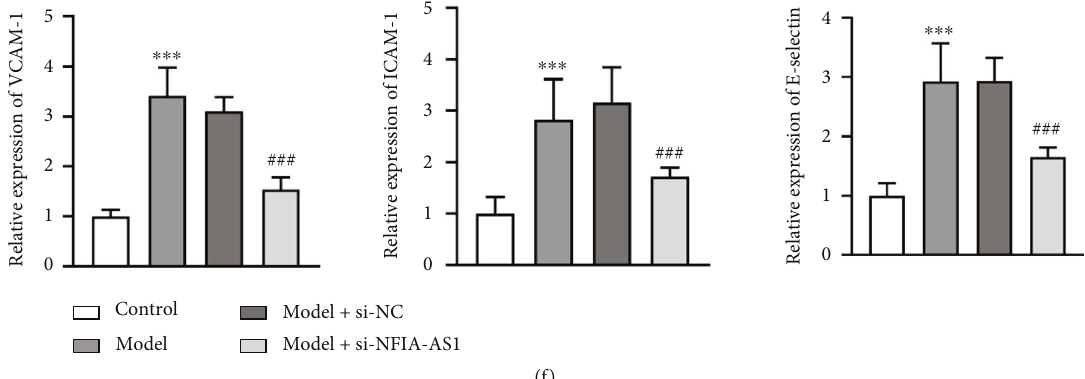
Figure 7: Inhibition of NFIA-AS1 improves the symptoms of AS. The relative expression of NFIA-AS1 (a), miR-125a-3p (b), and AKT1 (c) in control and AS model groups. *** P < 0 : 001 . (d) H&E staining of aortic vessels of mice in control, model, model+sh-NC, and model+si- NFIA-AS groups. Scale bar =100 μ m. (e) The levels of in fl ammatory cytokines IL-1, IL-1 β , TNF- α , and IL-6 in the serum of mice were determined by ELISA. (f) The levels of adhesion factors VCAM-1, ICAM-1, and E-selectin in the serum of mice were detected by qRT- PCR. *** P < 0 : 001 versus control group. ## P < 0 : 01 and ### P < 0 : 001 versus model+si-NC